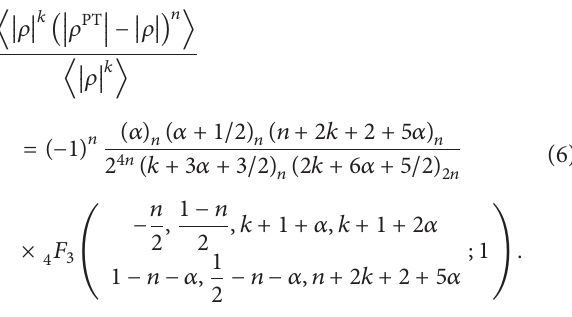
The range of the determinant difference variable (|𝜌 PT | −